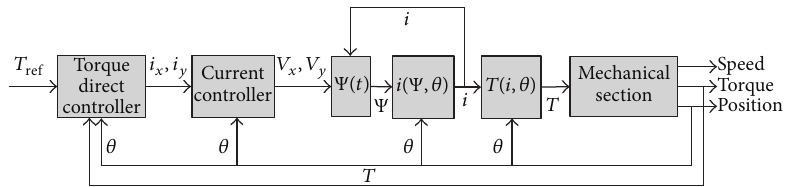
Figure 2: SRM model configuration.